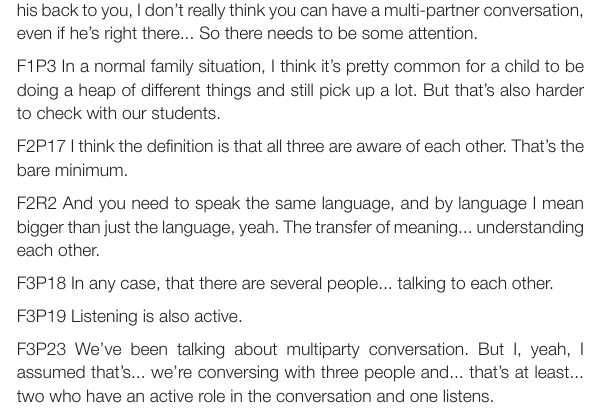
TABLE 3 | Thematic map. Theme Subthemes Operationalization of MPC Added value of MPC Social development Partner competencies for MPC